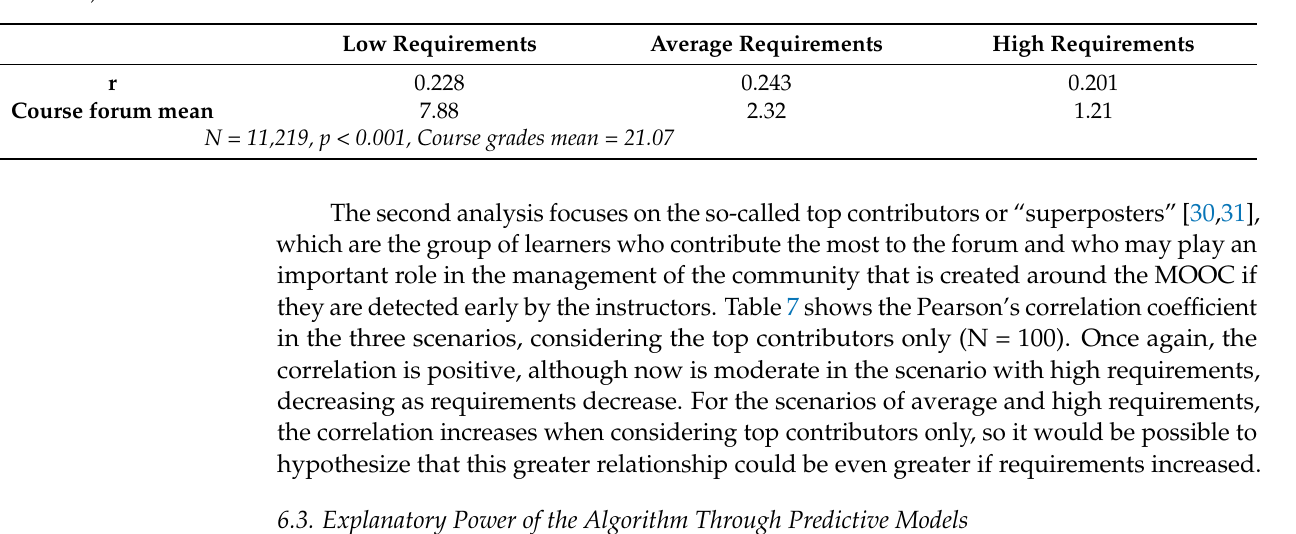
Table 6. Pearson’s correlation coefficient (Learners posting in the course forum OR attempting summative assessment